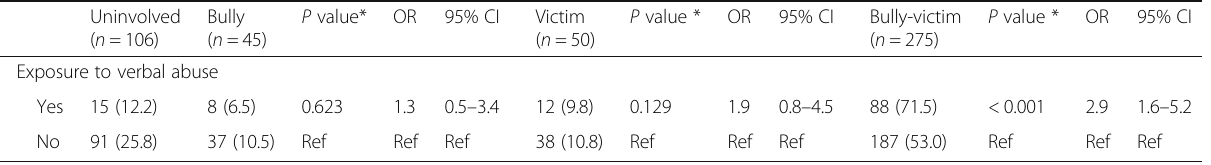
Table 2 Personal and family factors associated with bullying behavior among the studied group